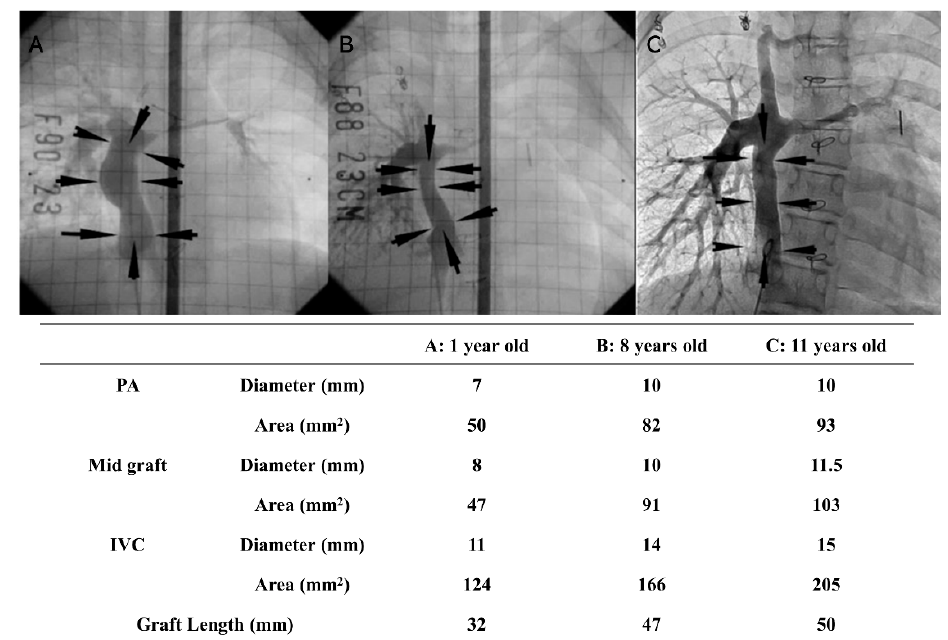
Figure 4. Three angiographic images in the same patient at different ages demonstrating growth of TEVG. ( A ) 1 year old, ( B ) 8 years old, ( C ) 11 years old. Arrows denote extracardiac TCPC graft. PA: Pulmonary artery; IVC: inferior vena cava. In 2001, the ethics committee at Tokyo Women’s Medical University approved the implantation of TEVGs in human subjects (IRB#198). The following inclusion criteria were used for patient screening elective surgery: age younger than 30 years, full understanding of the procedure by the patient or family, and minimal extracardiac disease burden. Informed consent was obtained from each patient, or from the parent/guardian if the patient was a minor, before proceeding.